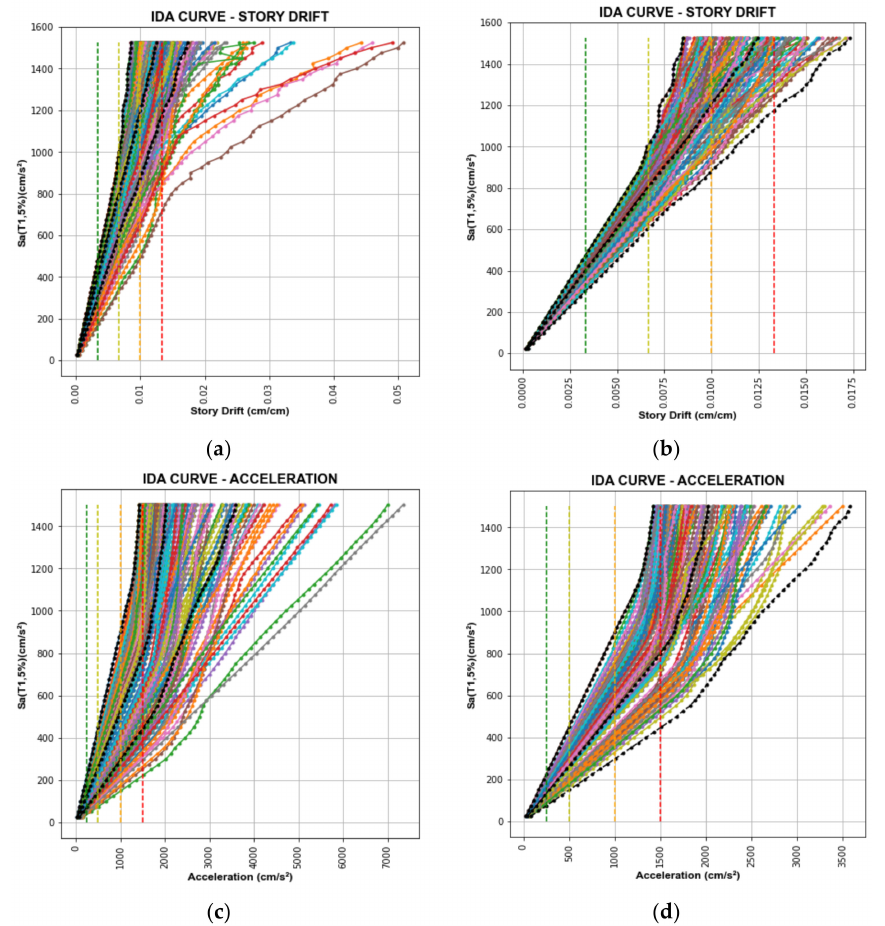
Figure 10. IDA Curves of Tahara City Hall Building. ( a ) IDA curves of the database for SD; ( b ) IDA curves of selected records for SD; ( c ) IDA curves of the database for AA; ( d ) IDA curves of selected records for